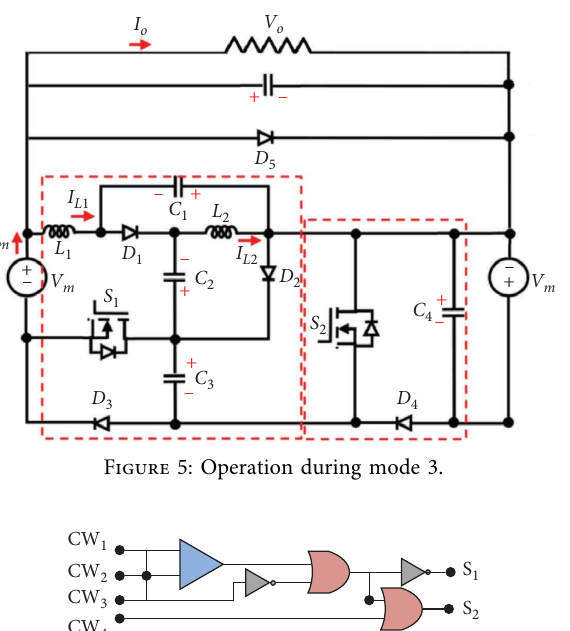
Figure 5: Operation during mode